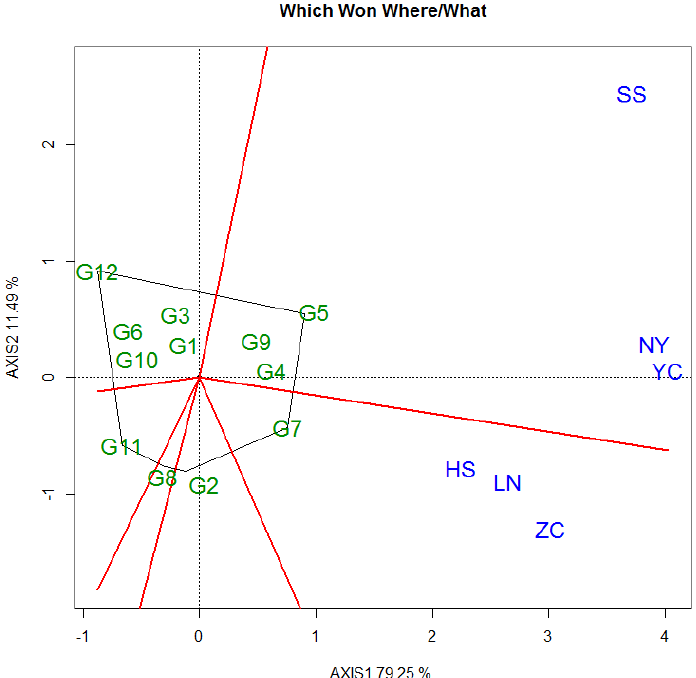
Figure 5. Biplot of “which won where” of DBH. The area formed by two adjacent red lines is an ME, where the genotype of the quadrilateral vertex is the best for the ME, and the remainder are good.